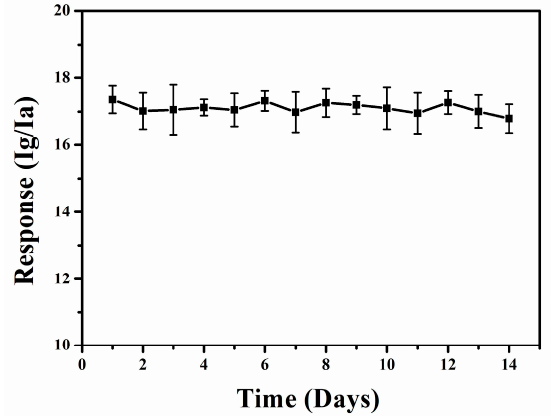
Figure 14. Response curve of the GO/ZnO nanosheet composites to 50 ppm n − propanol after 14 days of testing.